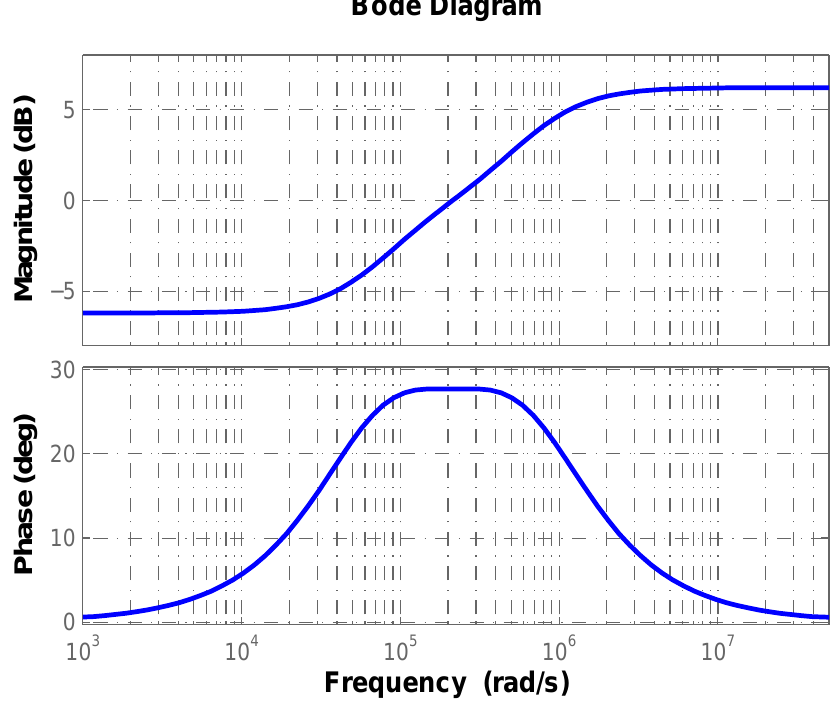
Figure 2. Frequency response for the approximation (10) with the fractional order α =